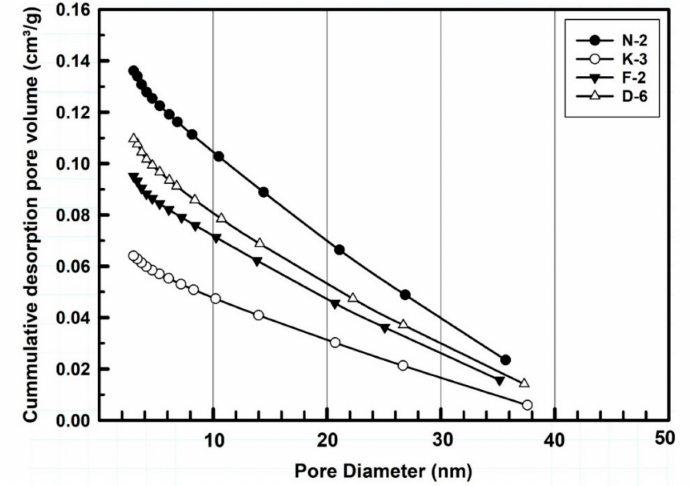
Figure 6. BJH-measured pore size distribution cumulative curves of the studied kaolin powder